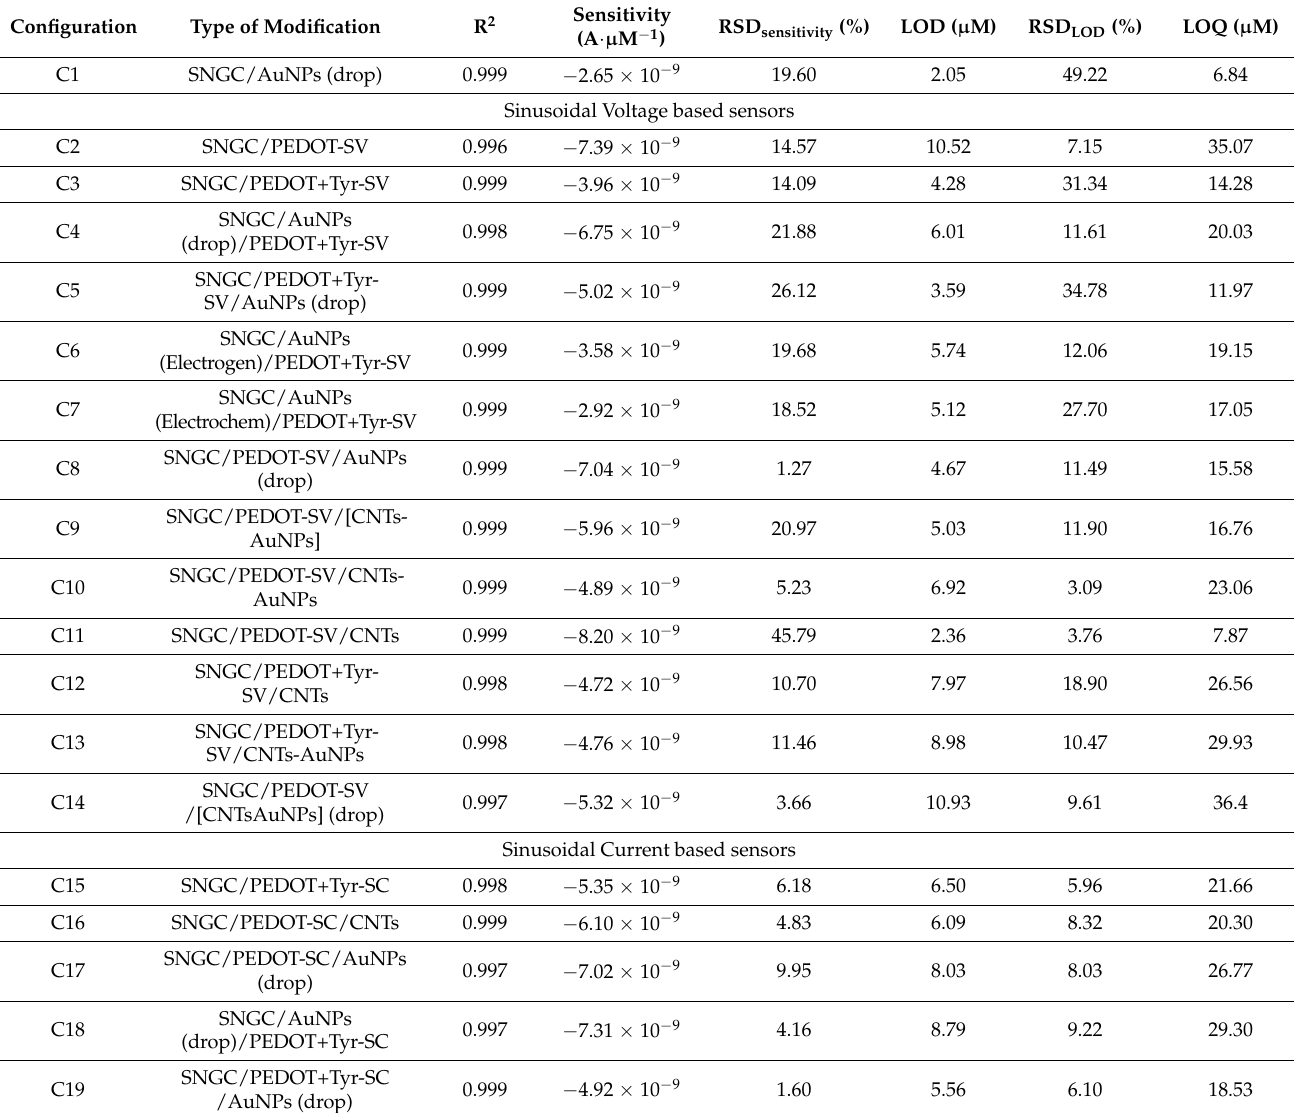
Table 2. Figures of merit obtained with the different modified (bio)sensors